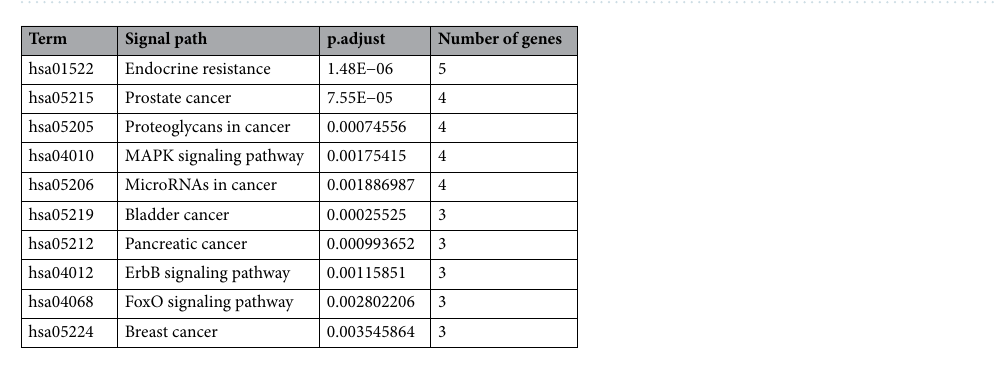
Table 2. KEGG enrichment analysis of core